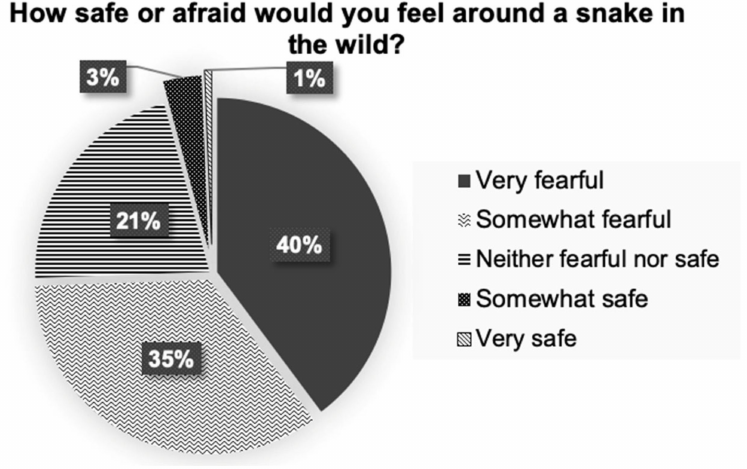
Figure 1. Participants’ perceptions of snakes in the wild.